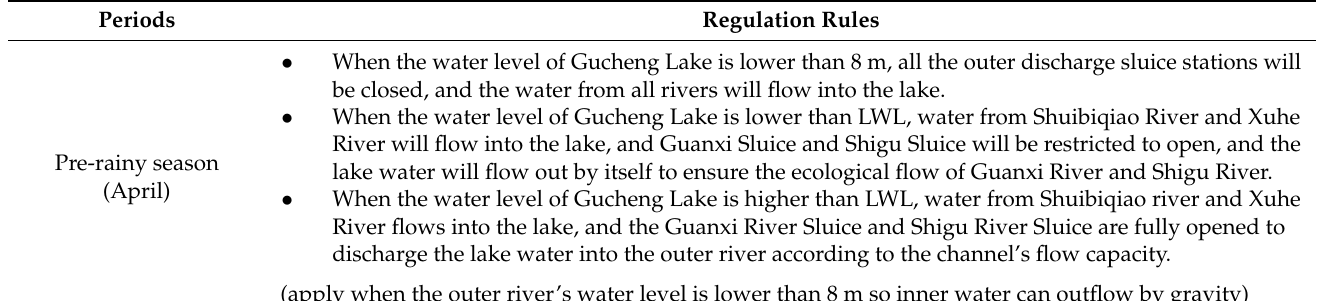
Table 3. Annual regulation rules for water